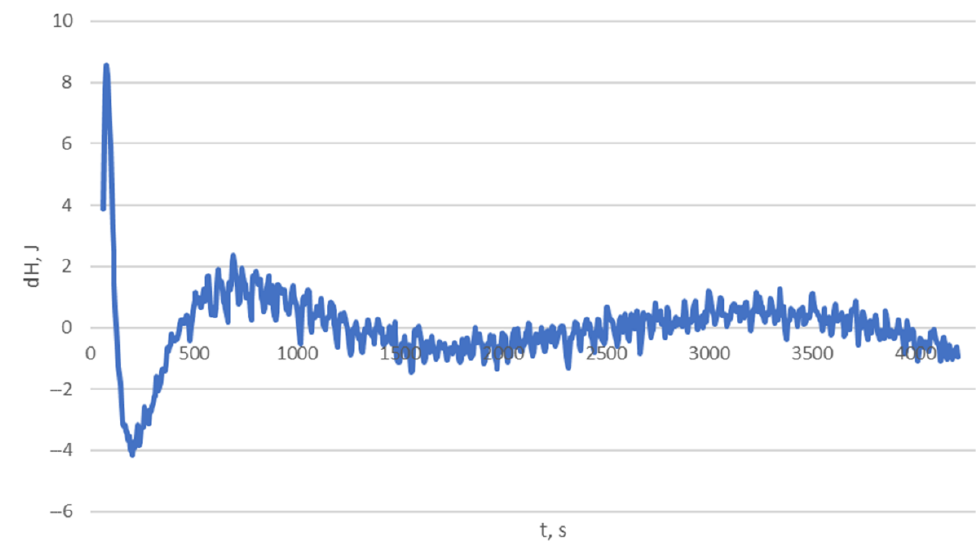
Figure 8. Residual enthalpy for T 0 Equation in (15) with coefficients from Table 4. Residual enthalpy decreases by more than 10 times, as shown in Figure 9. Table 4. The coefficients for Equation (15).